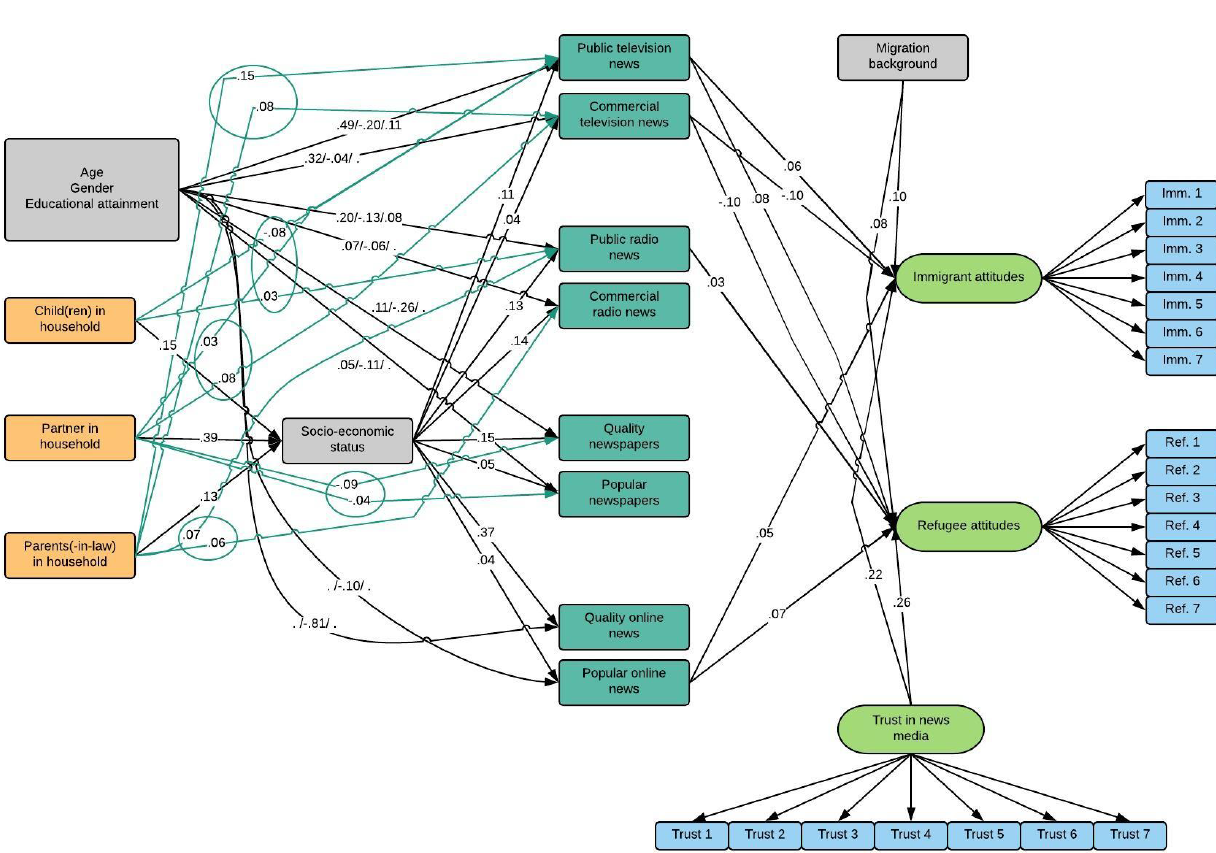
Table 3. Belgian mean of items on immigrant attitudes and refugee attitudes and other countries’ deviation from Belgian mean. Item description Belgium Sweden France Netherlands F1. Attitudes on immigrants Immigrants of same race or ethnicity as most of [ country ]’s population. 2.8 .28*** − .08*** − .02 Immigrants of a different race or ethnicity than most of [ country ]’s population. 2.4 .27*** − .06** .05* Immigrants of the richer countries in Europe. 2.7 .24*** − .05* .01 Immigrants of the poorer countries in Europe. 2.5 .27*** − .08** .01 Immigrants of the richer countries outside Europe. 2.4 .28*** − .04 .07** Immigrants of the poorer countries outside Europe. 2.3 .30*** − .06** .05* Immigrants coming from Muslim countries who wish to work in [ country ]. 2.2 .31*** − .06** .03 F2. Attitudes on refugees Refugees of the same race or ethnicity as most of [ country ]’s population. 2.8 .26*** − .09*** .02 Refugees of a different race or ethnicity than most of [ country ]’s population. 2.5 .25*** − .11*** .05* Refugees of the richer countries in Europe. 2.5 .23*** − .08** .03 Refugees of the poorer countries in Europe. 2.5 .24*** − .11*** .02 Refugees of the richer countries outside Europe. 2.4 .26*** − .11*** .05* Refugees of the poorer countries outside Europe. 2.4 .26*** − .11*** .05* Refugees coming from Muslim countries who wish to work in [ country ]. 2.3 .29*** − .08** .07**